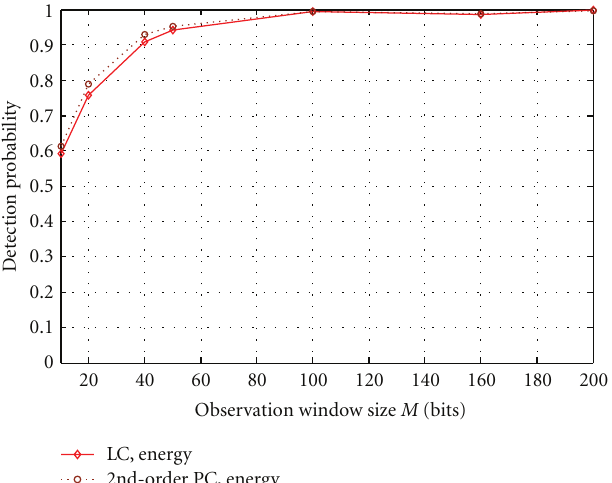
Figure 5: Impact of the window size on detection performance of energy-based schemes: SNR avg = − 5dB, N = 3 users, and P f = 10%.